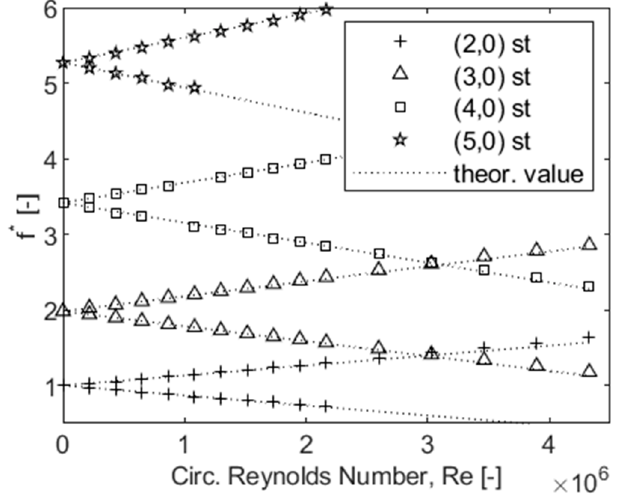
Figure 8. Normalized natural frequencies of structure dominant modes in air at 0.1MPa for “slim cavity” over circumferential Reynolds number. Experimental and theoretical results.